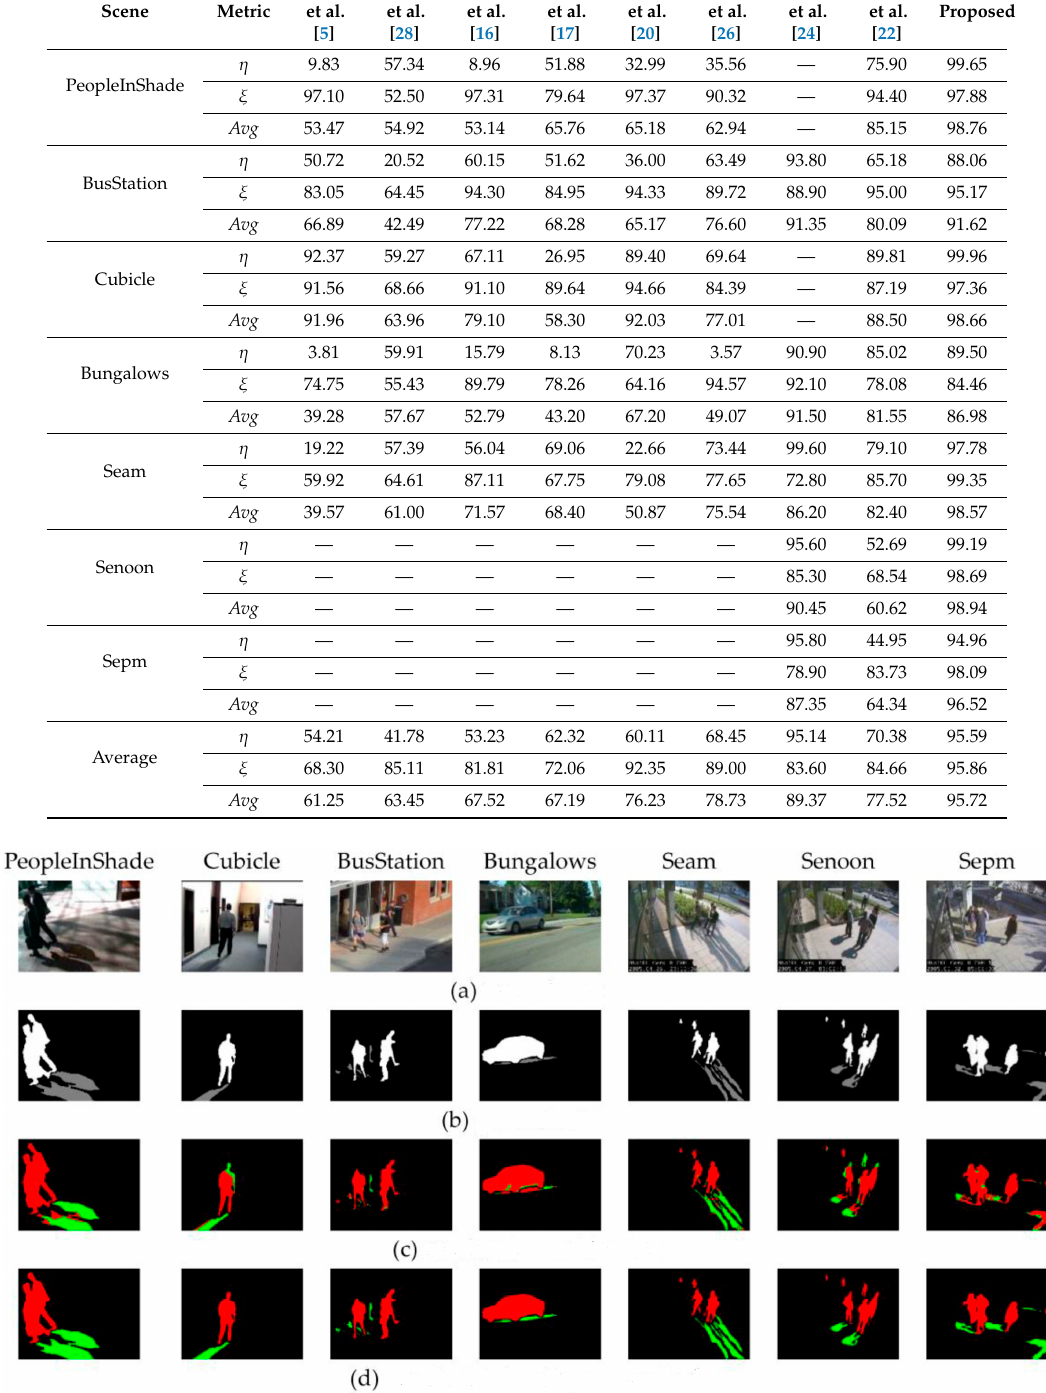
Figure 4. Visual comparisons of shadow-detection results on the large dataset. ( a ) input frame; ( b ) groundtruths; ( c ) results obtained by [22]; ( d ) results obtained by our